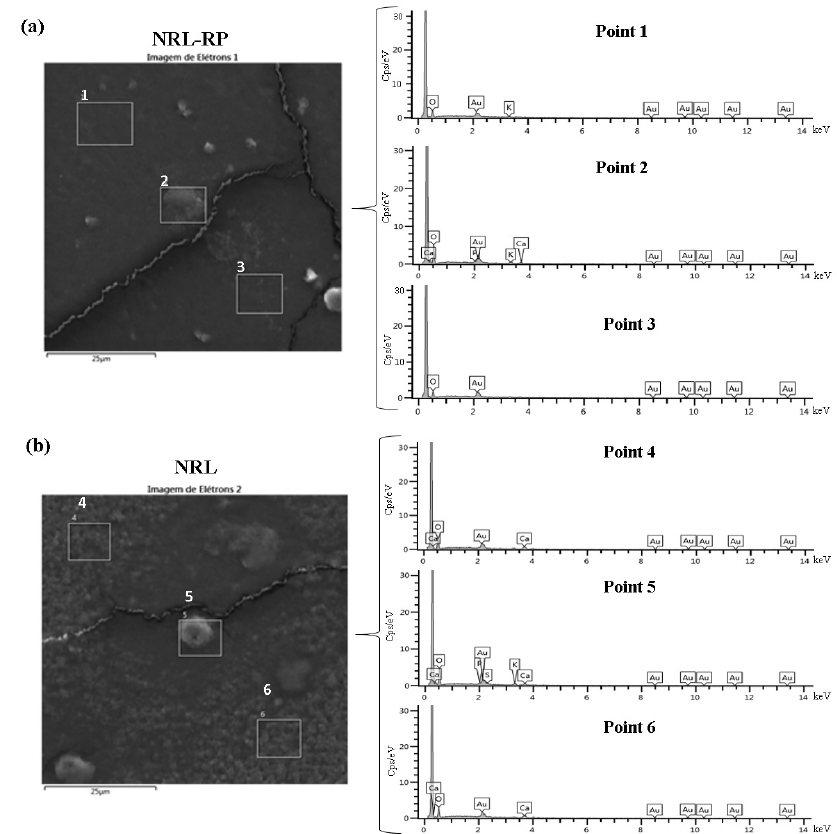
Figure 10. Elemental analysis through energy dispersive spectroscopy (EDS) micrographs: (a) NRL-RP and (b)